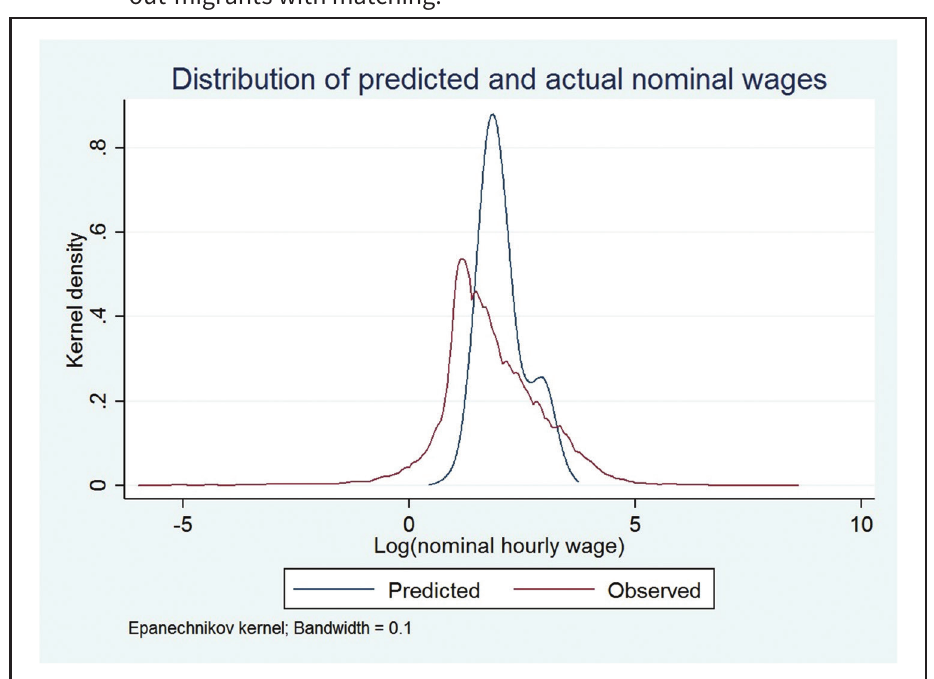
Figure 3 Kernel density plots of actual and predicted nominal wages of metropolitan out-migrants with matching.